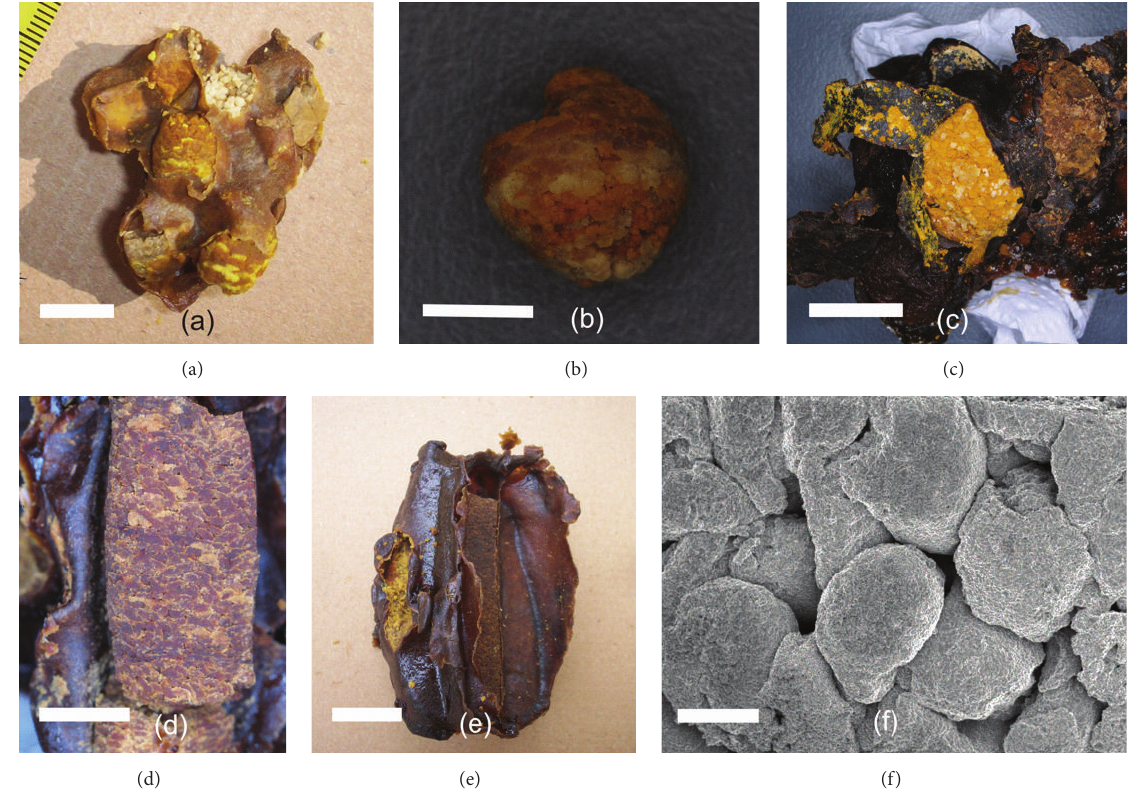
Figure 1: General aspect of pollen masses of Tetragonisca fiebrigi (a, b), Melipona orbignyi (c), and Geotrigona argentina (d, e). Individual loads from pollen masses can be seen in scanning microscope (f). Bars: (a) 10mm; (b) 5 mm; (c) 20 mm; (d) 10mm; (e) 20 mm; (f)